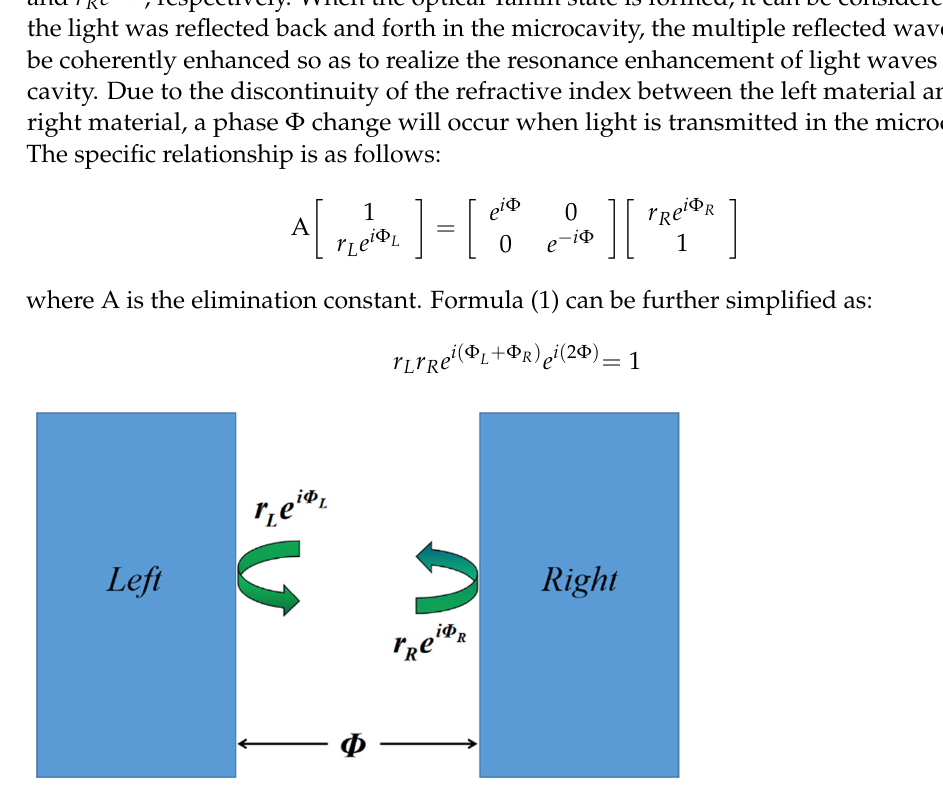
Figure 1. Schematic of the cavity.